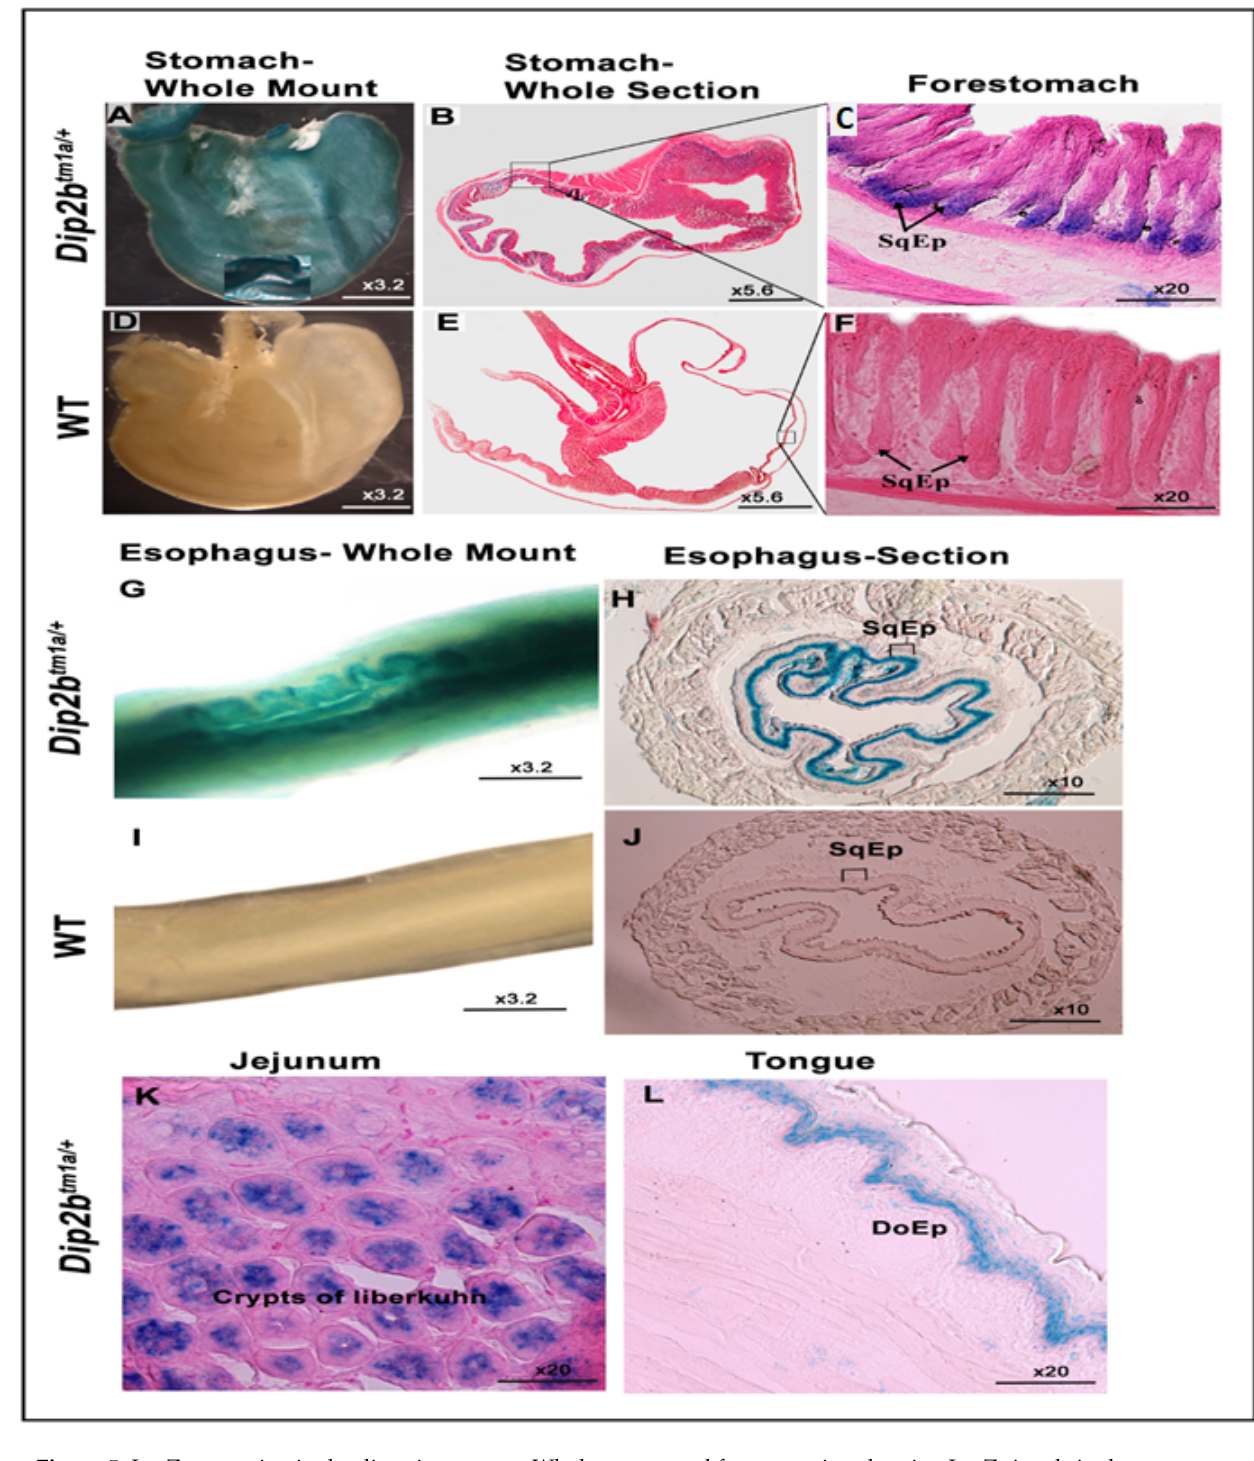
Figure 5. LacZ expression in the digestive system. Whole-mount and frozen section showing LacZ signals in the squamous epithelium (SqEp) of the fore stomach ( A – C ), esophagus ( G , H ), crypts of the Lieberkühn of the jejunum ( K ), and dorsal epithelium of the tongue ( L ). The control, labeled as WT, shows no staining ( D – F , I , J